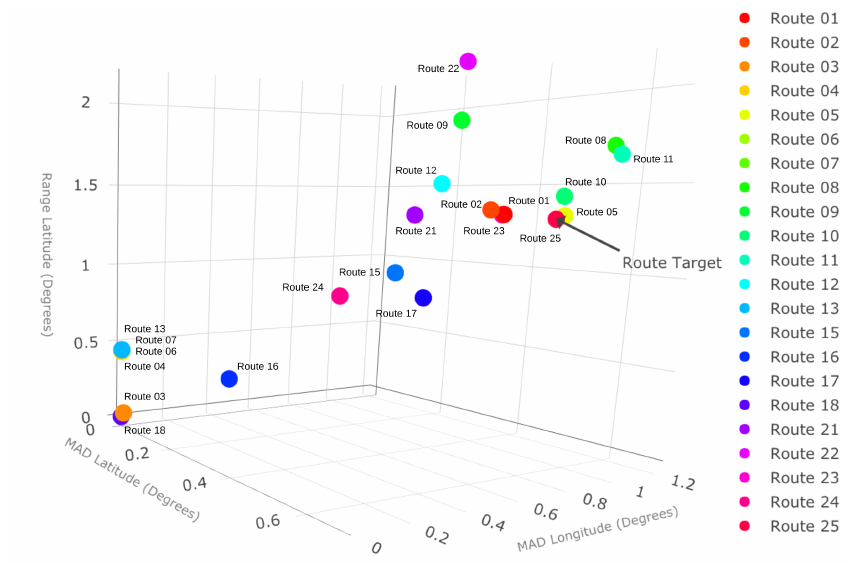
Figure 7. The actual and predicted routes.